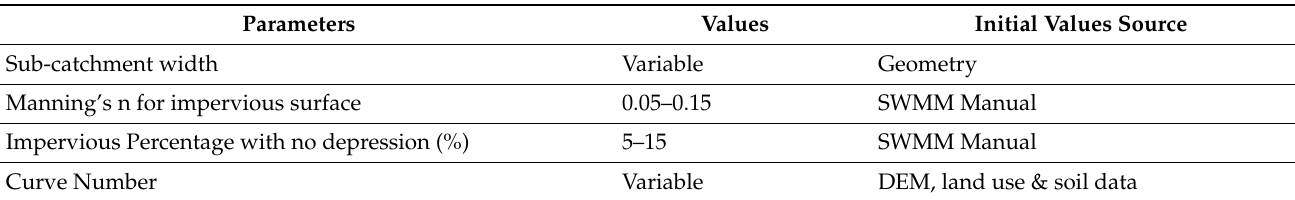
Table 2. SWMM parameters used for the sensitivity